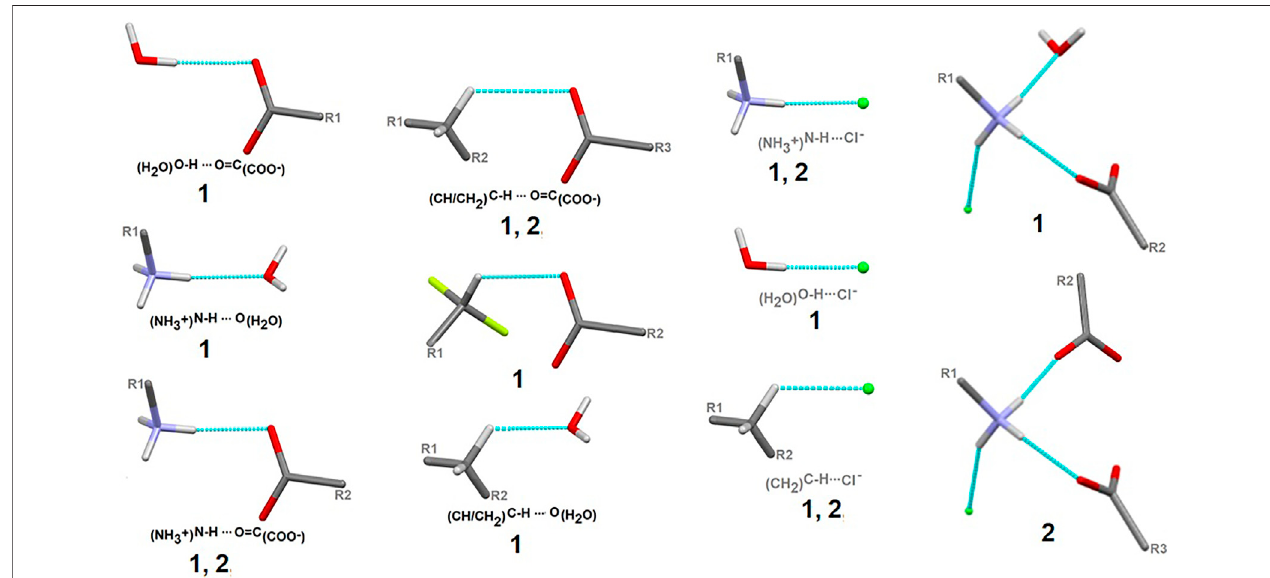
FIGURE7| SchematicdepictionofrepresentativemodelsofH-bondinteractions(synthons)withlabelsofanalyzedcrystalsinwhichthecorrespondingH-bonding pattern is present.